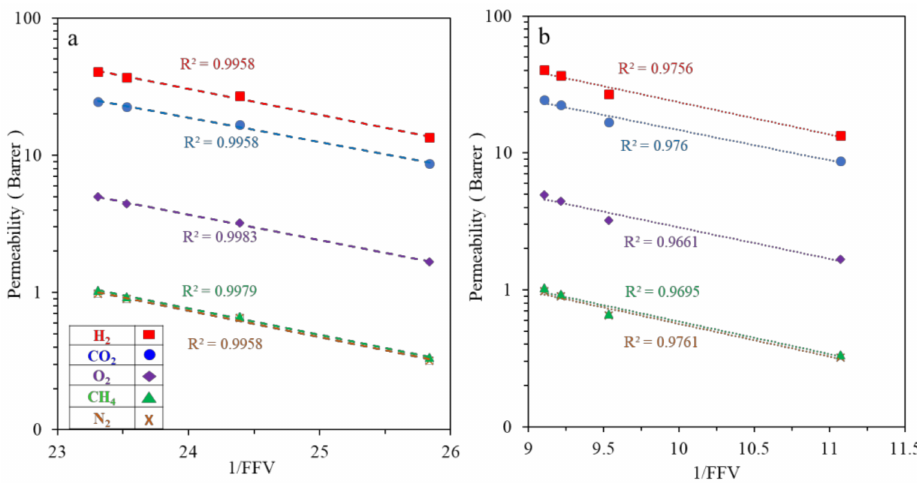
Figure 8. Relationship between permeability coefficient and 1/FFV. ( a ) FFV from PALS, ( b ) FFV calculation from Bondi’s way.